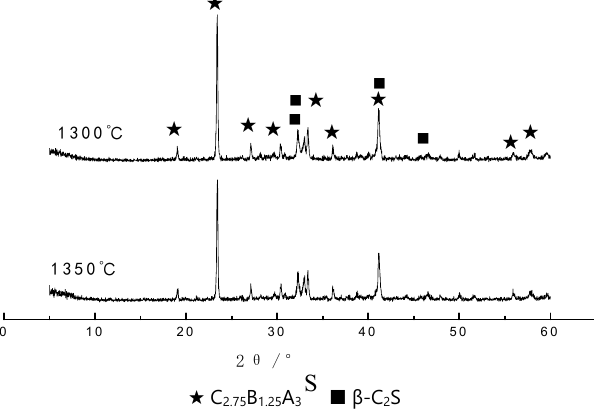
Figure 11. XRD patterns of F3 at different